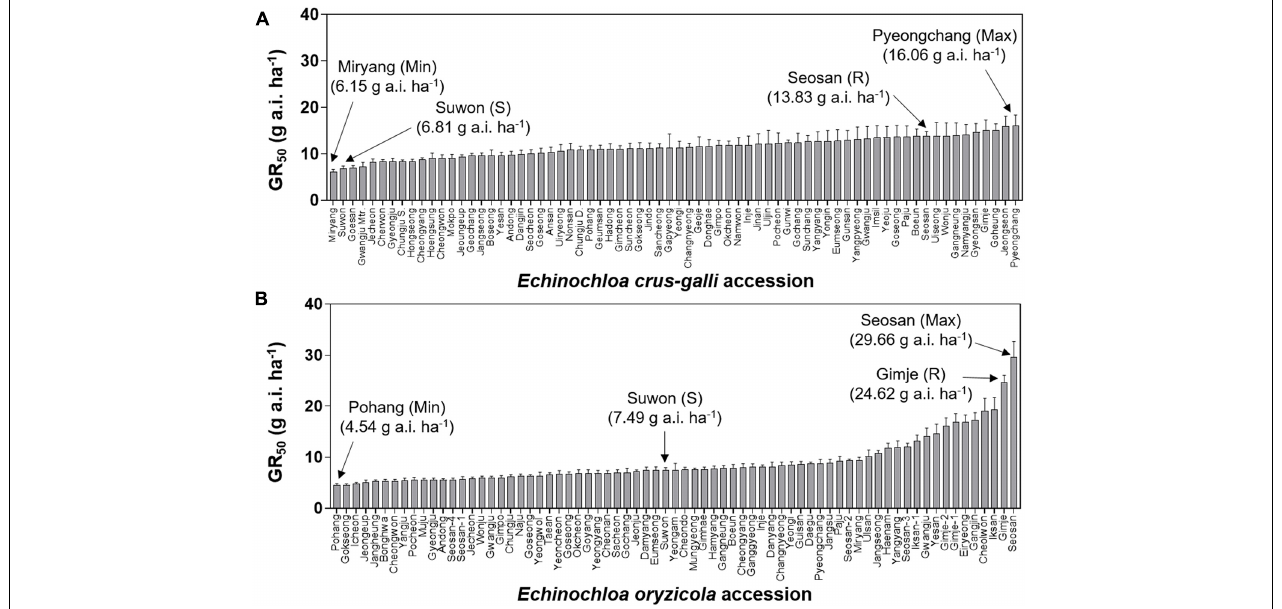
FIGURE 3 | GR 50 values of florpyrauxifen-benzyl for (A) Echinochloa crus-galli and (B) Echinochloa oryzicola accessions.